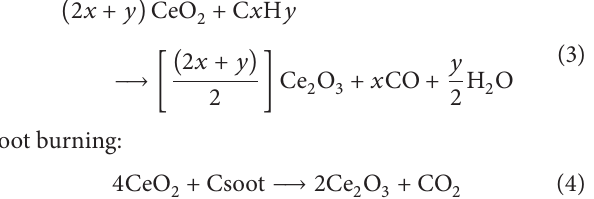
Figure 11: Variation of HC emissions with load for diesel and modified diesel (35ppm of CeO 2 ) for different vol % of surfactant (DDSA).